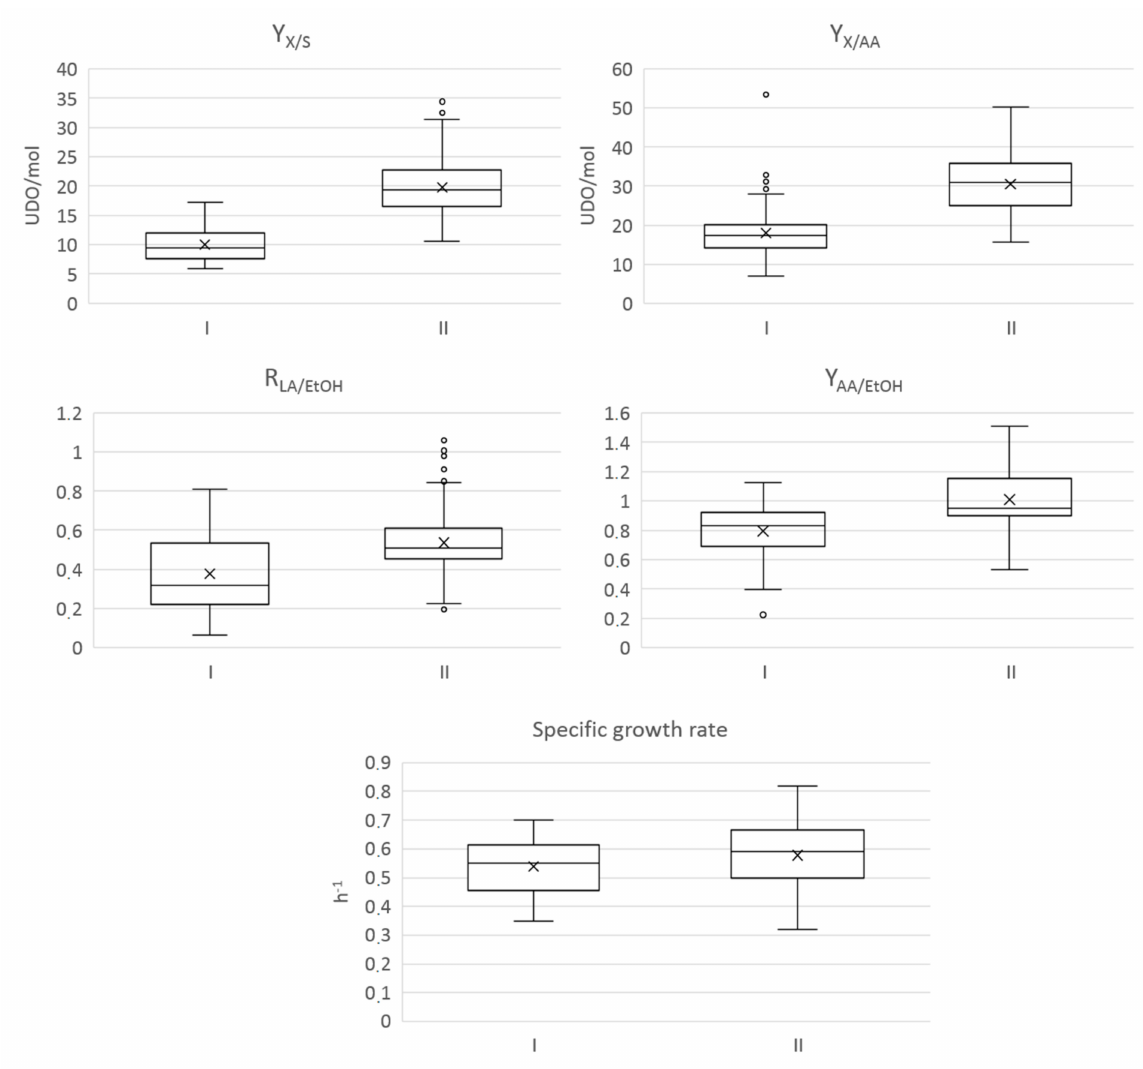
Figure 2. Comparisons in boxplots of the physiological traits of Acetobacter pasteurianus strains from different geographical origins and one type of strain according to the two large clusters. Y EtOH/AA = conversion efficiency of ethanol into acetic acid, R LA/EtOH = the lactic acid consumption divided by the ethanol consumption, Y X/S = biomass yield, Y X/AA = biomass yield produced by the acetic acid produced and the specific growth rate in h − 1 . Where X is the biomass, S = substrates consumption, LA = lactic acid, AA = acetic acid. EtOH =